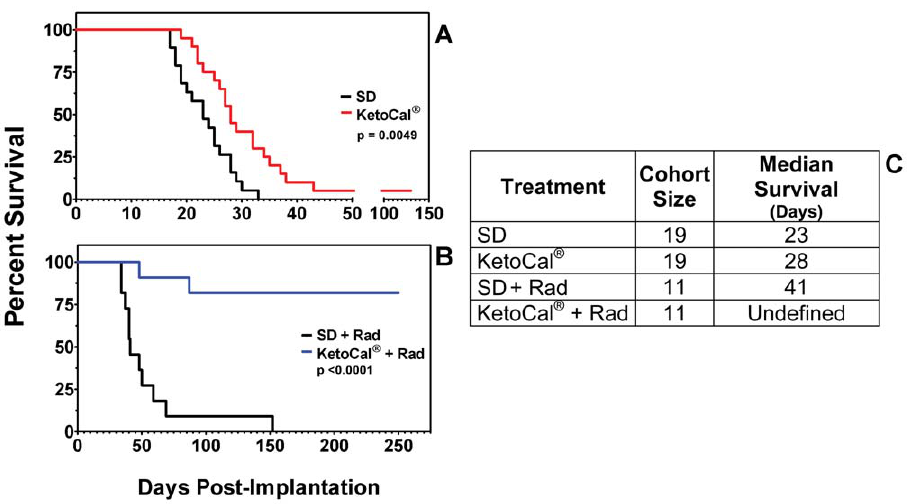
Figure 1. KetoCal H enhances survival of glioma-bearing mice. Kaplan-Meier plot of survival in KC versus SD (A), radiation versus KC plus radiation (B). Animals on KC survived significantly longer when treated with KC alone (p , 0.005), or when combined with radiation (p , 0.0001). Results are a combination of (A) 4 separate experiments and (B) 2 separate experiments.